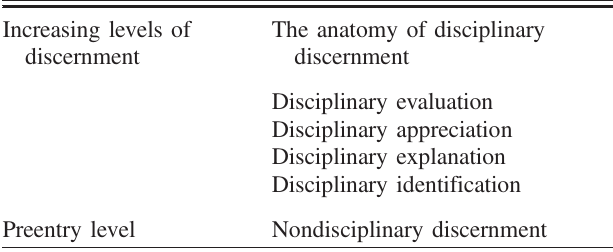
TABLE I. The hierarchy of the anatomy of disciplinary discern- ment (ADD). For details, see Eriksson et al.